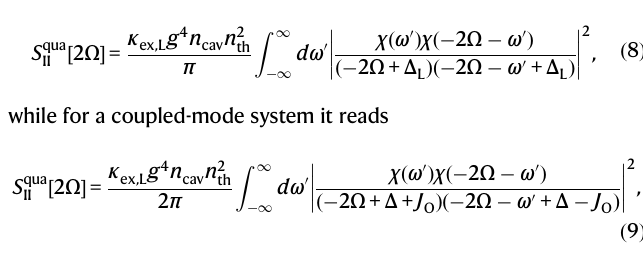
displacement ( ∣ u ∣ ) pro fi le of a simulated mechanical supermode, which is an odd combinationoftheleftandrightcavitymodes.Notethatthedepictedamplitudeof motion is largely exaggerated. An angle of θ =20 ∘ between the crystal axis and nanobeam was used for this